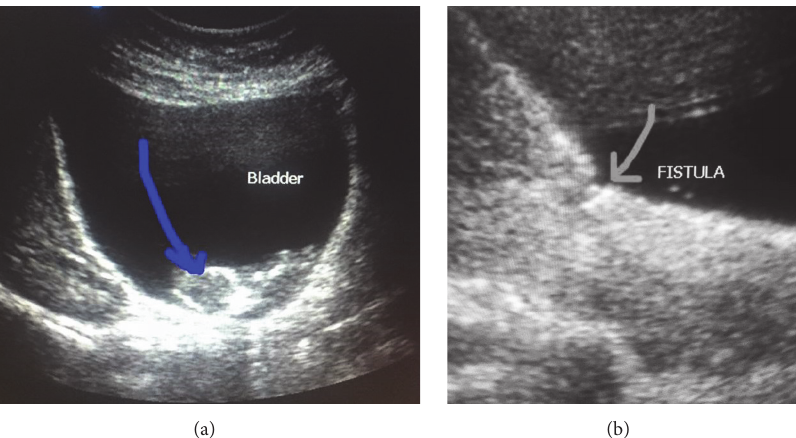
Figure 1: Ultrasound images demonstrate (a) a fetus in the mother’s bladder and (b) the fistulous tract between the cavities of the uterus and bladder.